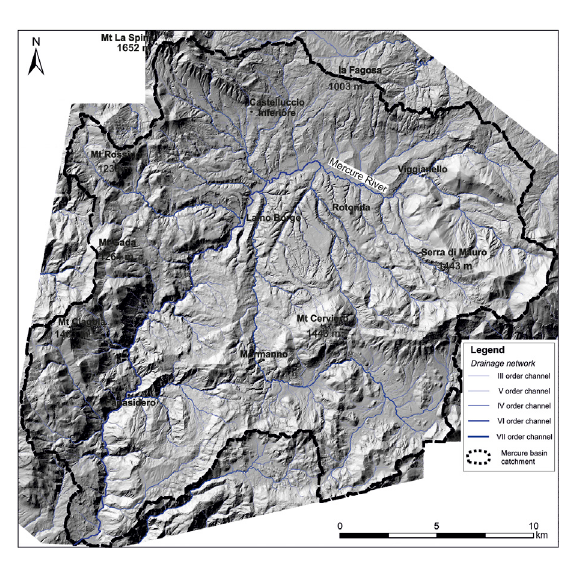
FIGURE 5 Catchment and drainage network of the Mercure River basin draped over the hillshade of the study area. Hierachization of the drainage net follows the Strahler ’ s